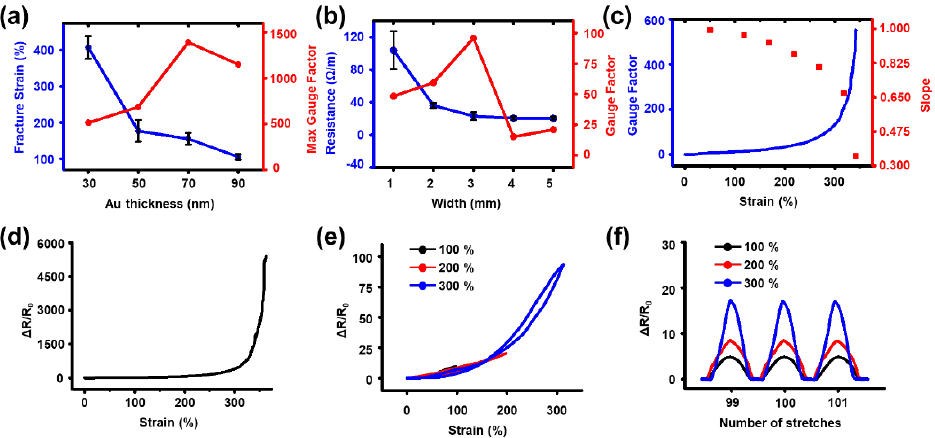
Figure 4. ( a ) Fracture strain and maximum gauge factor of the Au–SEBS strain sensor with their respective Au thicknesses. ( b ) Resistance trends and gauge factor as per the width of the strain sensor. ( c ) Gauge factor and linearity change as per the strain for determining the range of use of the sensor. ( d ) Relative resistance – strain curve depicting the sensitivity of the selected strain sensor. ( e ) Relative resistance – strain curve depicting the hysteresis of the selected strain sensor under a double sweep. ( f ) Reliable strain-sensing performance of the selected strain sensor under repeated stretching cycles.